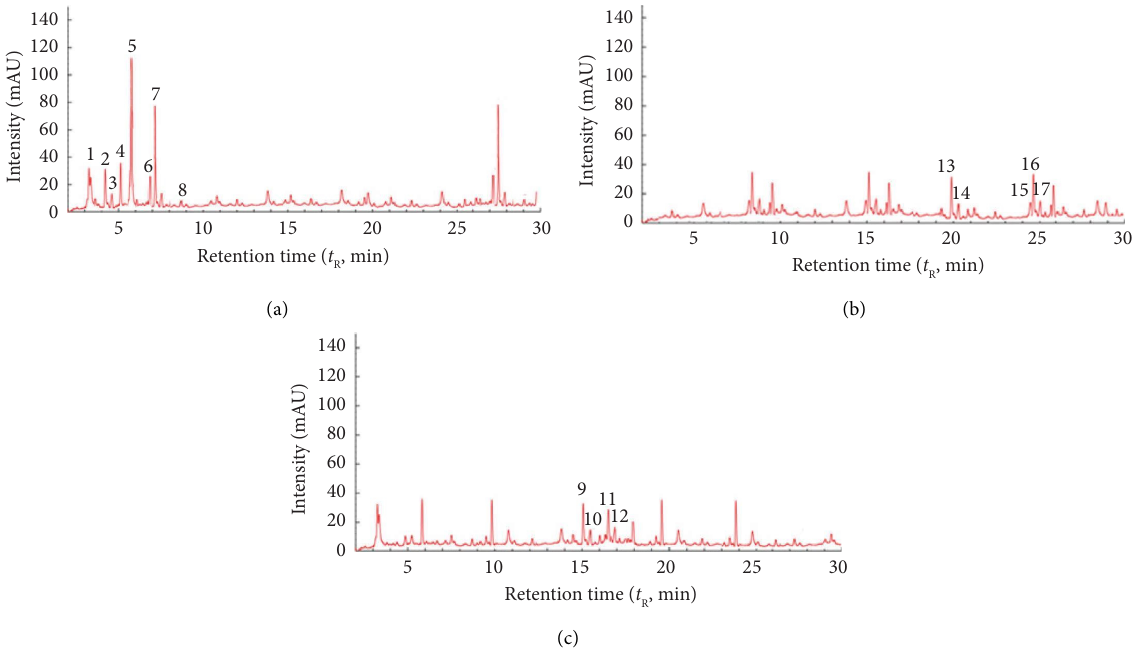
Figure 1: HPLC profles at 325nm (a), 354nm (b), and 560 nm (c) of the grape pomace extract obtained using water.